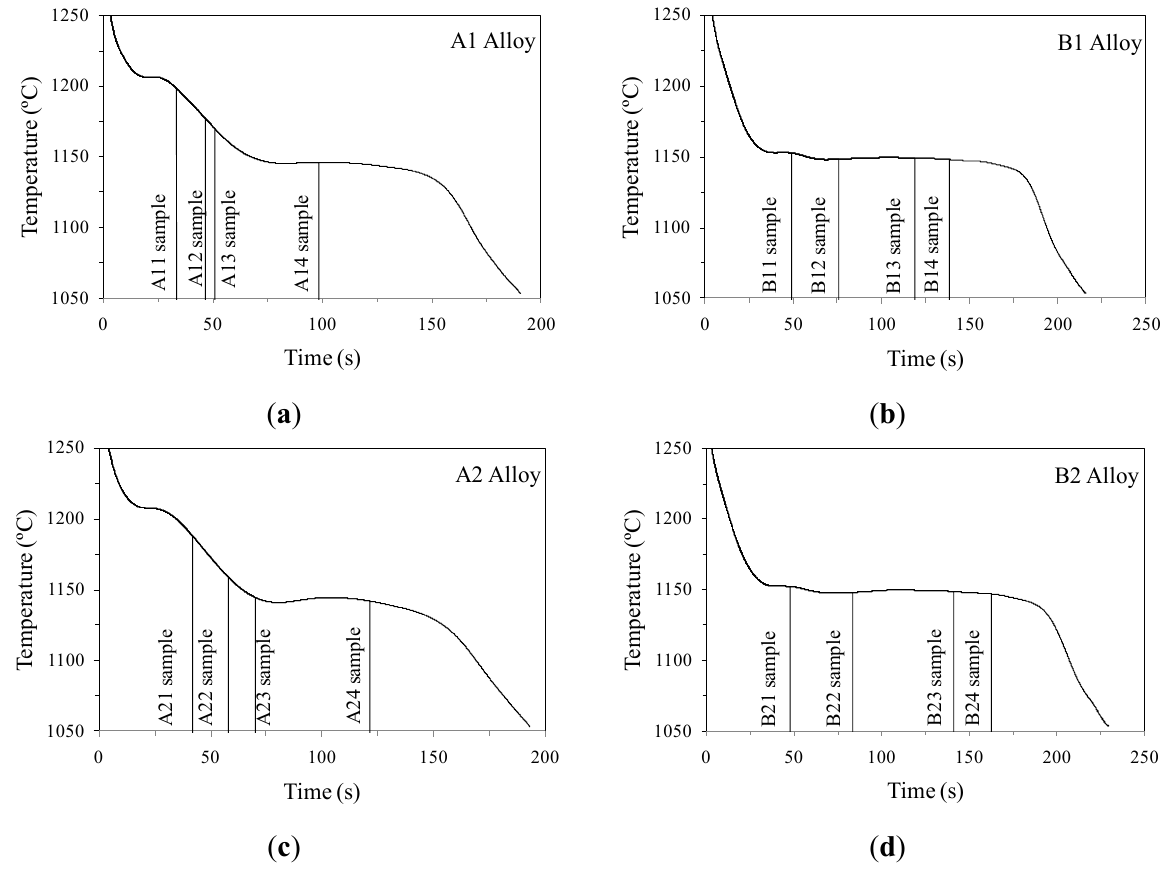
Figure 3. Quenching experiments made for each cast iron alloy. ( a ) A1 Alloy; ( b ) B1 Alloy. ( c ) A2 Alloy; ( d ) B2